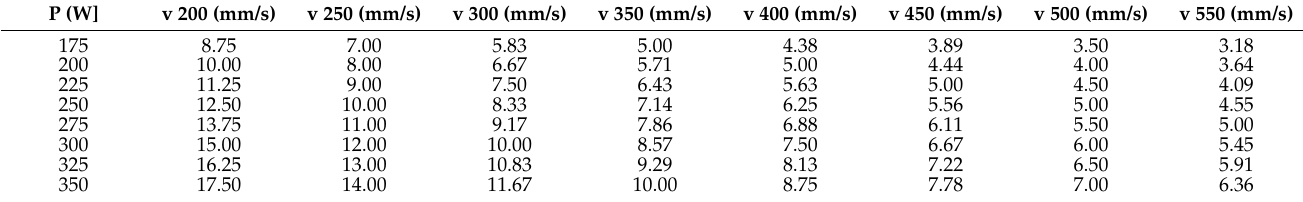
Table 5. Proposed matrix of process parameters (area energy density E 2 (J/mm 2